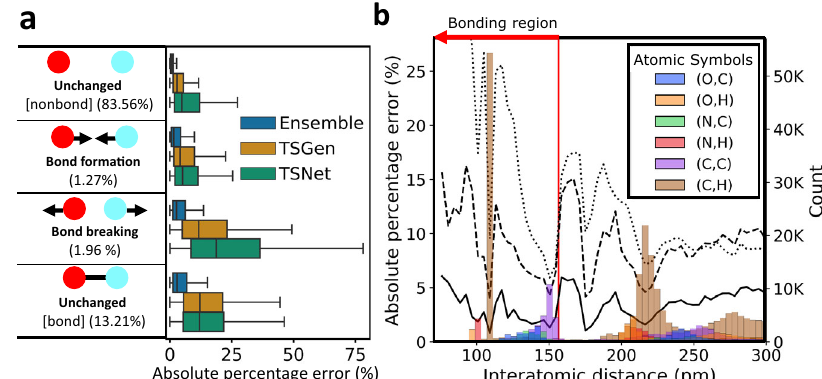
Fig.2|ErroranalysisofMLpredictions.a Boxplotofabsolutepercentageerrorsof four interatomic pairs depending on bond change types during a reaction. Blue, orange, and green boxes represent the prediction errors of TSNet, TSGen, and the ensemble approach, respectively. The percentages in parentheses represent the ratio ofthetypeofinteratomicpairamongtheentiretrainingset.Thepresenceorabsence of chemicalbondsin reactantsand productsis simpli fi edasdetermining whetherthe interatomic distance is <156.6pm. b Absolute percentage errors and numbers of atomic pairs with different element sets according to interatomic distance. The